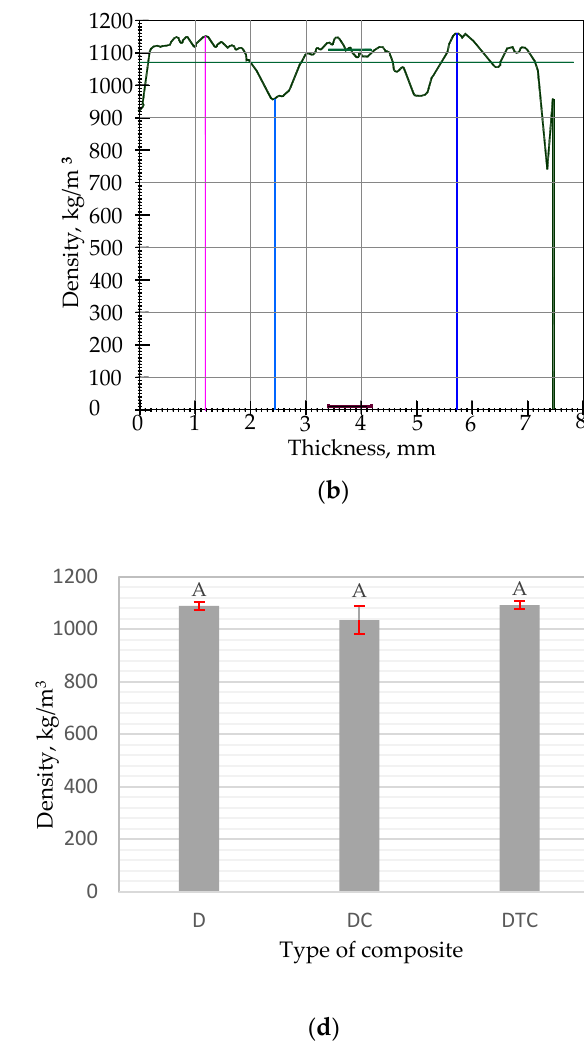
Figure 4. Vertical density profiles of the tested composites: ( a ) D; ( b ) DC; ( c ) DTC; ( d ) average values of measured densities.